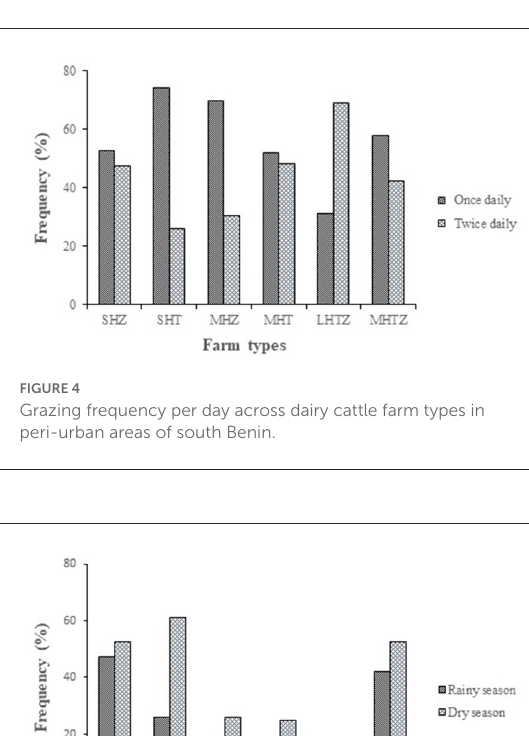
The constraints faced by livestock keepers in the study area did not vary across farm types but were significantly ( P < 0.001) different between municipalities (Figure